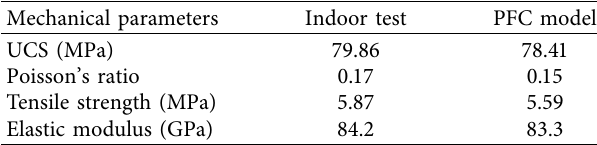
Figure 4: Schematic of the Brazilian splitting test. Table 1: Mechanical parameters of Jinping marble.